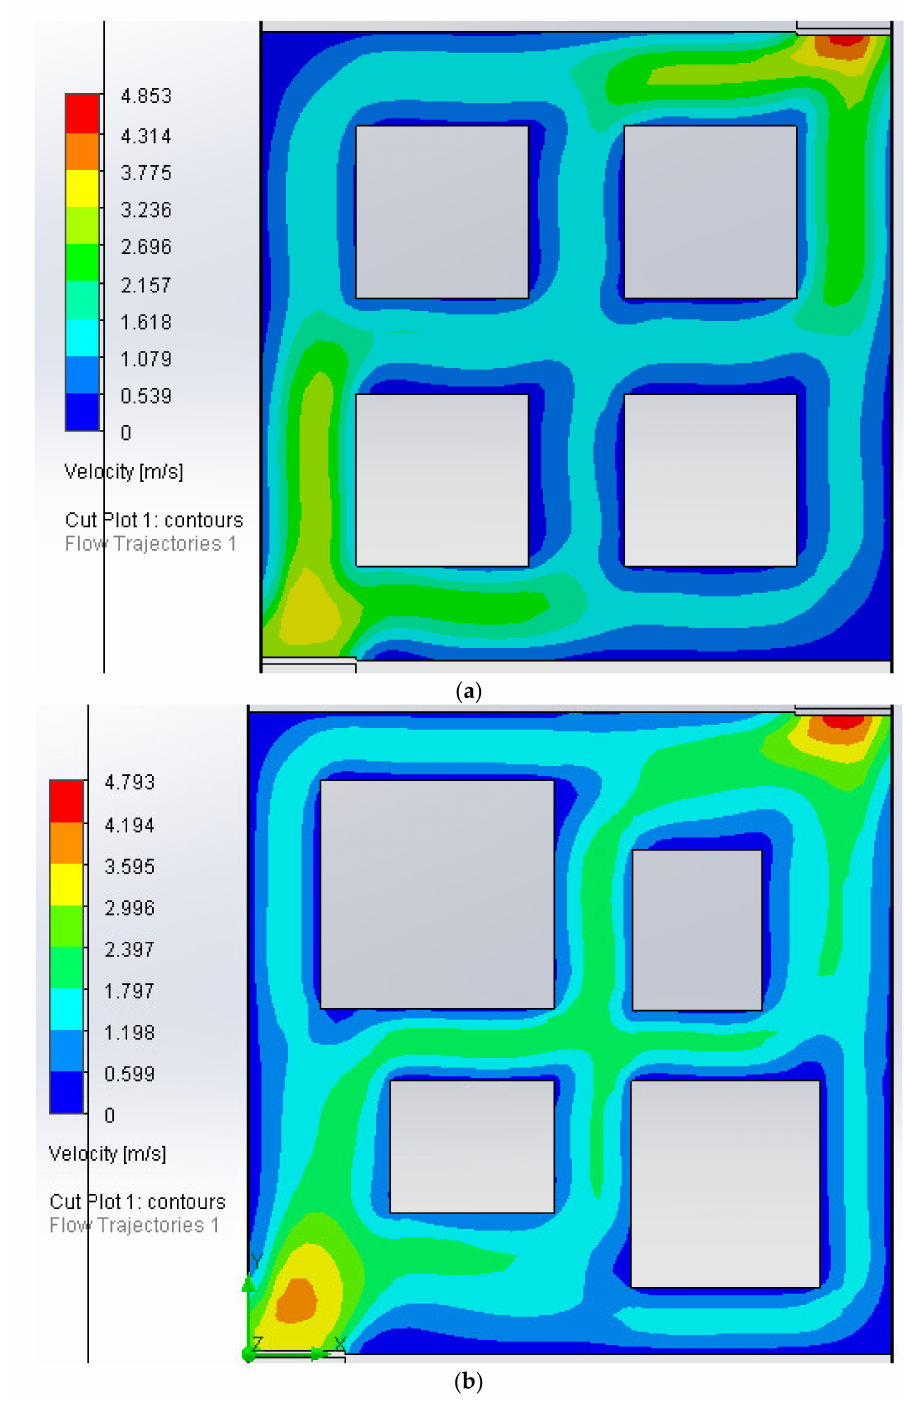
Figure 11. Velocity contour plot for 3 × 3 flow field in m/s ( a ) unoptimized design; ( b ) MOGA